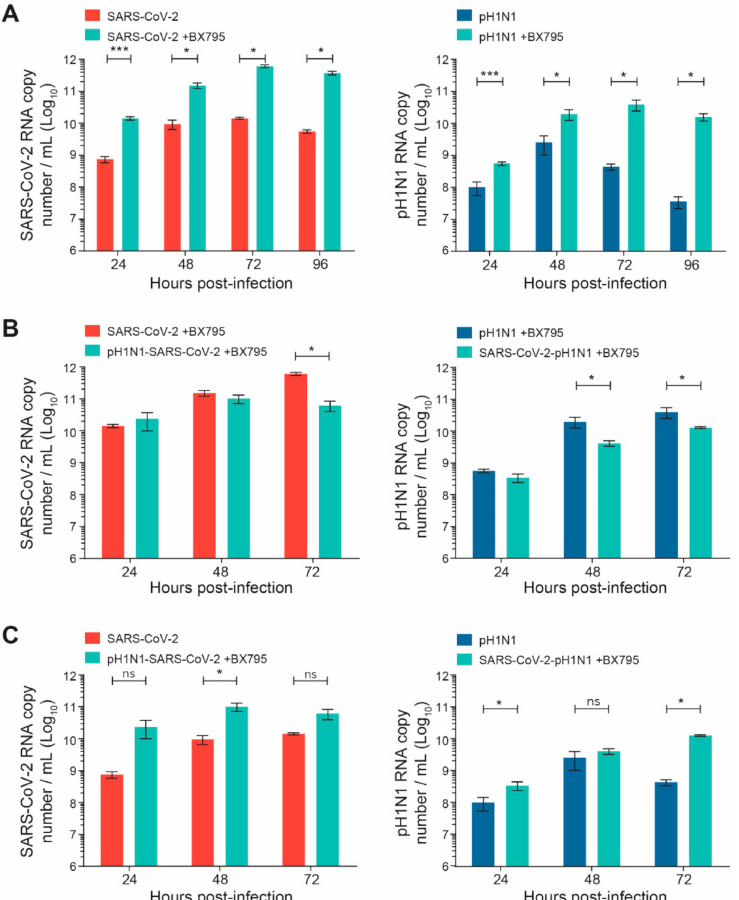
Figure 4. Effects of a pretreatment of nasal human airway epithelium (HAE) with BX795 on single or sequential infection with SARS-CoV-2 and influenza A(H1N1)pdm09 virus. Nasal HAE were pretreated with BX795 at the basal pole, and the medium was replaced by a fresh medium containing BX795 every 24 h during the infection. After 24 h, HAE was sequentially infected (24 h apart) with SARS-CoV-2/influenza A(H1N1)pdm09 virus combinations at the apical pole. Single infections with each virus were performed in parallel. The MOI was set at 0.015 in single and dual infections. Viral loads of both viruses were determined by RT-qPCR. ( A ) Effects of BX795 on replication kinetics of SARS-CoV-2 or influenza A(H1N1)pdm09 virus during single infections. ( B ) Effects of BX795 on the replication kinetics of SARS-CoV-2 and influenza A(H1N1)pdm09 during sequential and single infections. ( C ) Comparison of the replication kinetics of SARS-CoV-2 and A(H1N1)pdm09 during sequential infections in presence of BX795 and single infections without BX795. Results are the mean ± SEM of 2 independent experiments performed in duplicate in HAE. ns, not significant; * p < 0.05; *** p < 0.01 by Mann–Whitney test. pH1N1, influenza A(H1N1)pdm09